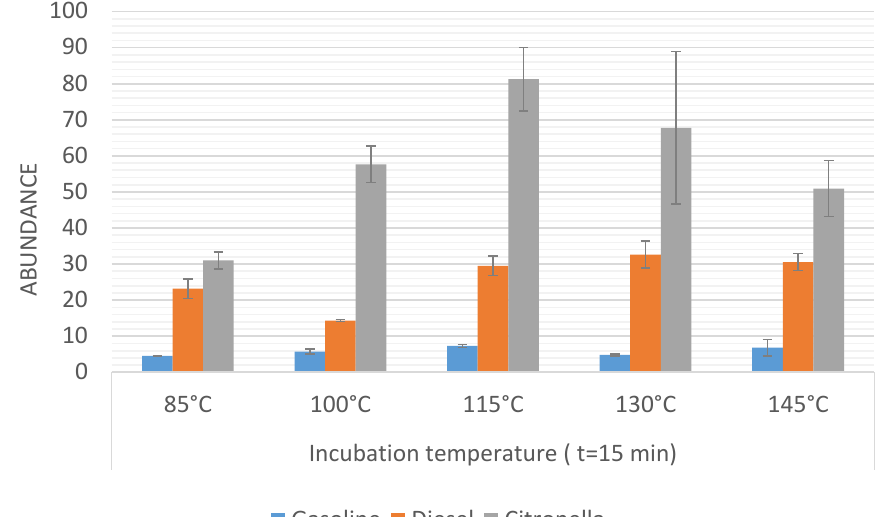
Figure 2. Sum abundance values obtained for the burned samples Gpw , Dpw , and Cpw . Heating time 15 min at different incubation temperatures. Bars with the same letter for the same ILR indicate a non-significant difference ( p < 0.05) according to ANOVA analysis.